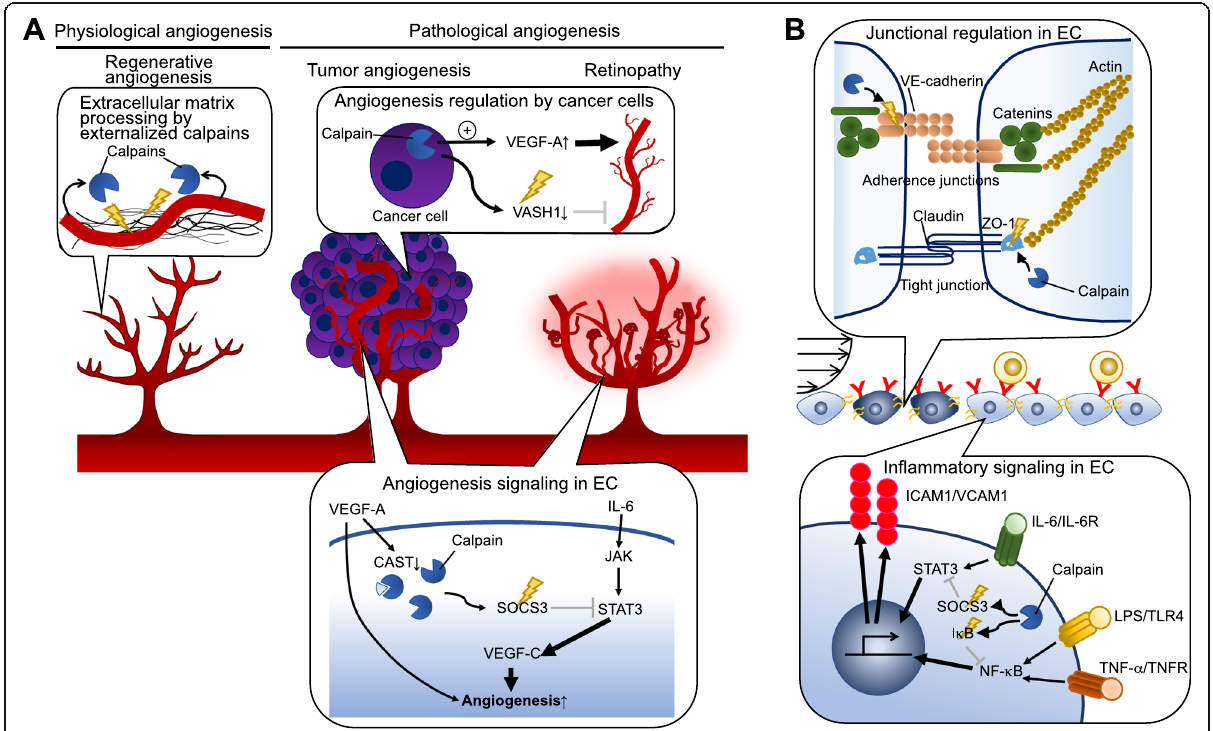
Fig. 2 Calpain systems disturb EC adaptation to the inflammatory environment. a Conventional calpains can accelerate angiogenic responses in ECs. While conventional calpains externalized by ECs exert processing of extracellular matrix thereby accelerating regenerative angiogenesis, those in ECs can potentiate pathological angiogenesis, such as tumor angiogenesis and retinopathy. Mechanistically, calpain-induced proteolysis of SOCS3 accelerates cytokine-driven production of VEGF-C. VEGF-C can synergize with VEGF-A; thus, angiogenic responses in ECs can be excessive in the presence of redundant cytokine stimuli. Furthermore, conventional calpains in cancer cells degrade VASH1, an angiogenesis inhibitor, and potentiate the production of VEGF-A. Accordingly, calpains in cancer cells positively regulate tumor angiogenesis. b Conventional calpains can proteolyze the juxtamembrane domain of VE-cadherin, leading to the disorganization of adherence junctions in ECs. Furthermore, tight junction- associated protein ZO-1 can be degraded by calpain. As a result, overactivation of conventional calpains can disrupt junctional integrity in ECs. Concomitantly, calpain proteolyzes intracellular negative regulators of inflammatory signaling, such as I κ B and SOCS3, in the cells. This amplifies cytokine responses in ECs, when the cells are subjected to the additional inflammatory stimuli. CAST: calpastatin; EC: endothelial cell; ICAM-1: intercellular adhesion molecule-1; IL-6: interleukin-6; IL-6R: interleukin-6 receptor; I κ B: inhibitor κ B; JAK: Janus kinase; LPS: lipopolysaccaride; NF- κ B: nuclear factor- κ B; STAT3: signal transducer and activator of transcription 3; SOCS3: suppressor of cytokine signaling 3; TLR4: toll-like receptor 4; TNF- α : tumor necrosis factor- α ; TNFR: tumor necrosis factor receptor; VASH1: vasohibin-1; VCAM-1: vascular cell adhesion molecule-1; VE-cadherin: vascular endothelial-cadherin; VEGF: vascular endothelial growth factor; ZO-1; zonula